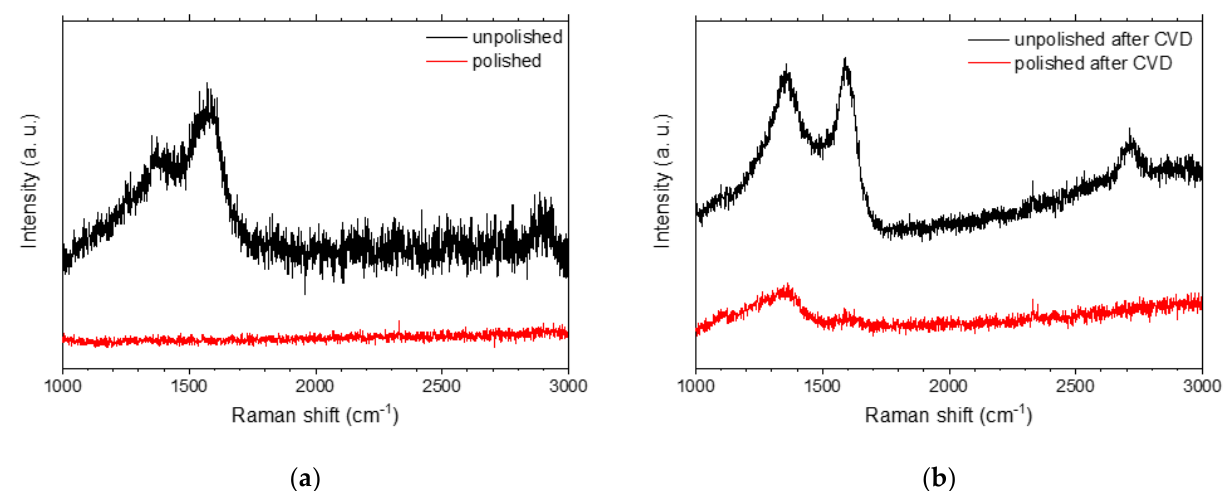
Figure 5. Raman spectra of the unpolished (cut only) and the polished Co-Cr alloy samples (before ( a ) and after CW-CVD ( b )).